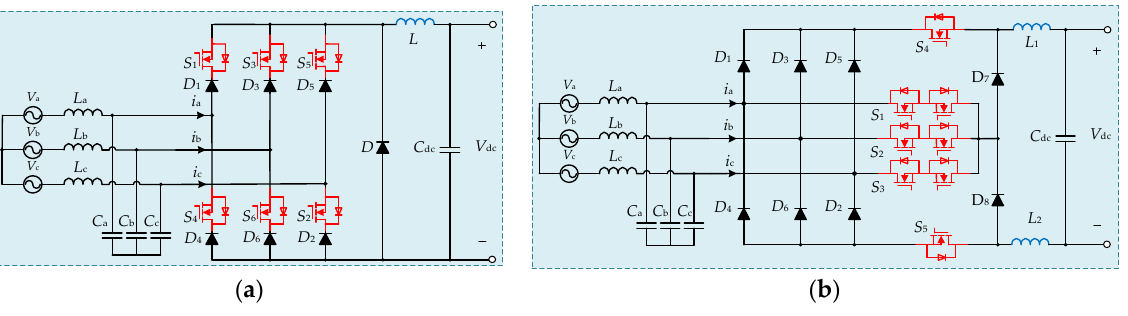
Figure 7. Three-phase buck-type recti fi er topology. ( a ) Three-phase six-switch buck recti fi er. ( b ) Swiss recti fi er.